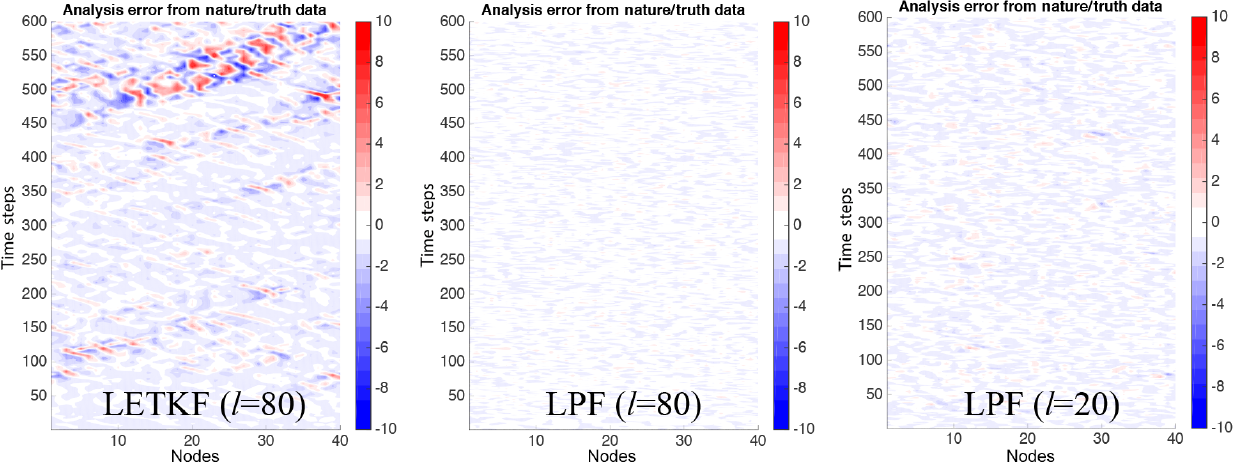
Figure 7. Analysis error for (a) LETKF and (b) LPF, using l = 80 observations and k = 100 ensemble members. The observations used between (a) and (b) are identical. In (c) , the number of observations for LPF is reduced to l = 20, but improvement in accuracy vs. LETKF remains.